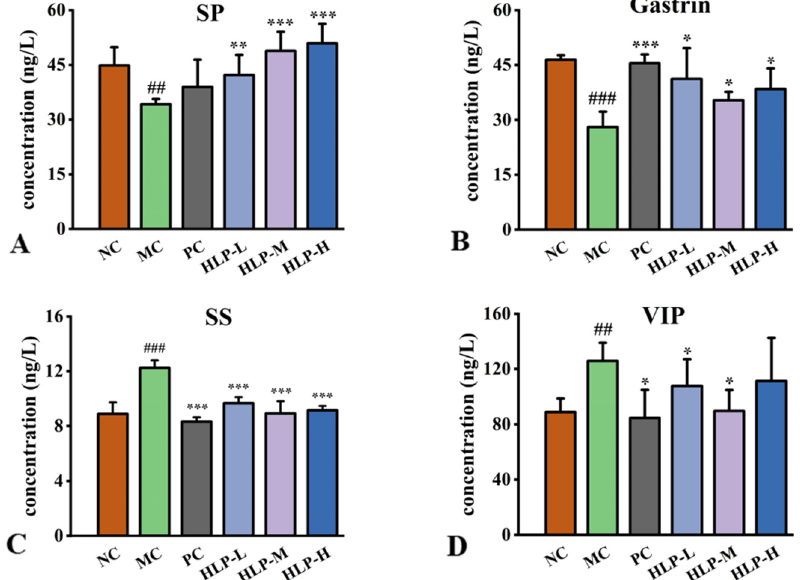
Figure 3. Gastrointestinal regulatory-related peptides content in mice. ( A ) SP: substance P. ( B ) Gastrin. ( C ) SS: somatostatin. ( D ) VIP: vasoactive intestinal peptide. ## p < 0.01, ### p < 0.001 vs. NC group; * p < 0.05, ** p < 0.01, *** p < 0.001 vs. MC group.NC: normal control group, MC: model control